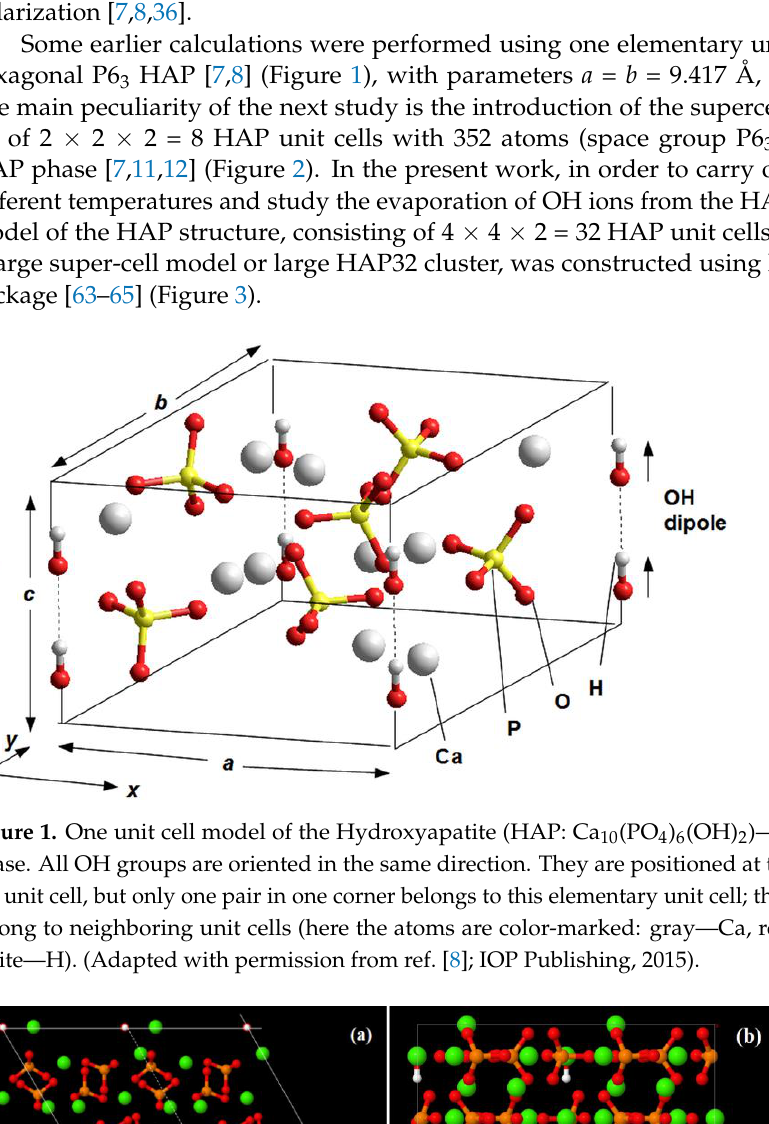
Figure 3. Images of large HAP32 supercell models with 4 × 4 × 2 = 32 unit cell of HAP and 1408 atoms: ( a ) top view — along the c axis of the OH channel (a yellow line highlights the one unit cell and green lines show one 2 × 2 × 2 supercell with OH-channel in the center); ( b ) big HAP supercell model in isometric projection from c-axis, surrounded by water molecule layers with 1504 water molecules.